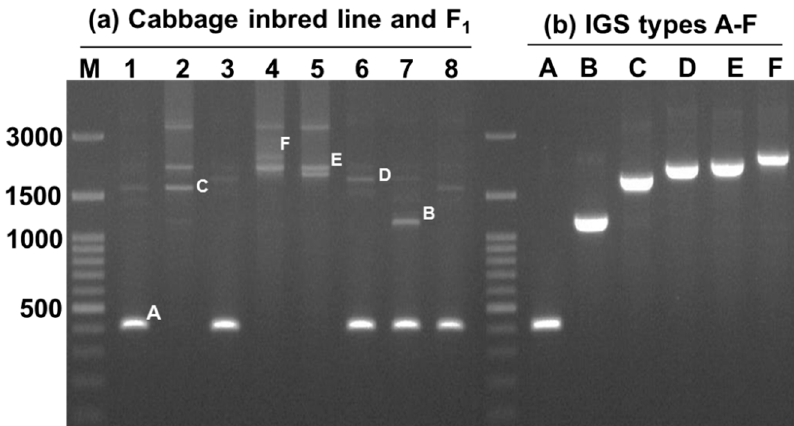
Figure 2. Different types of IGS (A to F types) identified in cabbage lines. ( a ) IGS regions identified in three cabbage inbred lines and five F 1 plants and ( b ) cloned bands representing the six types of IGS amplified using specific PCR primers designed at the 25S-end and 18S-start regions.